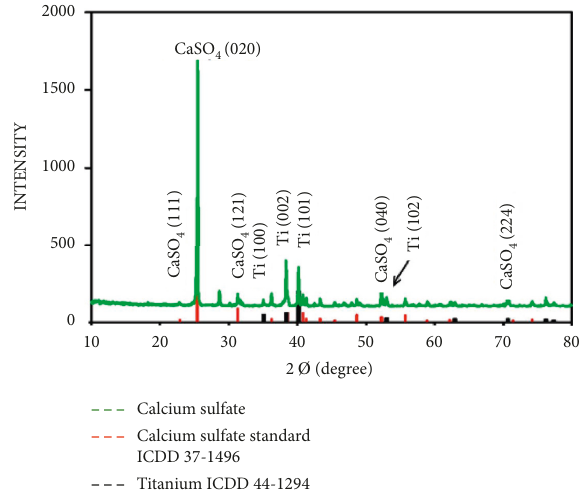
Figure 4: X-ray diffraction pattern of Cp Ti sample coated with nano calcium sulfate and (PVA, PVP) as a binding